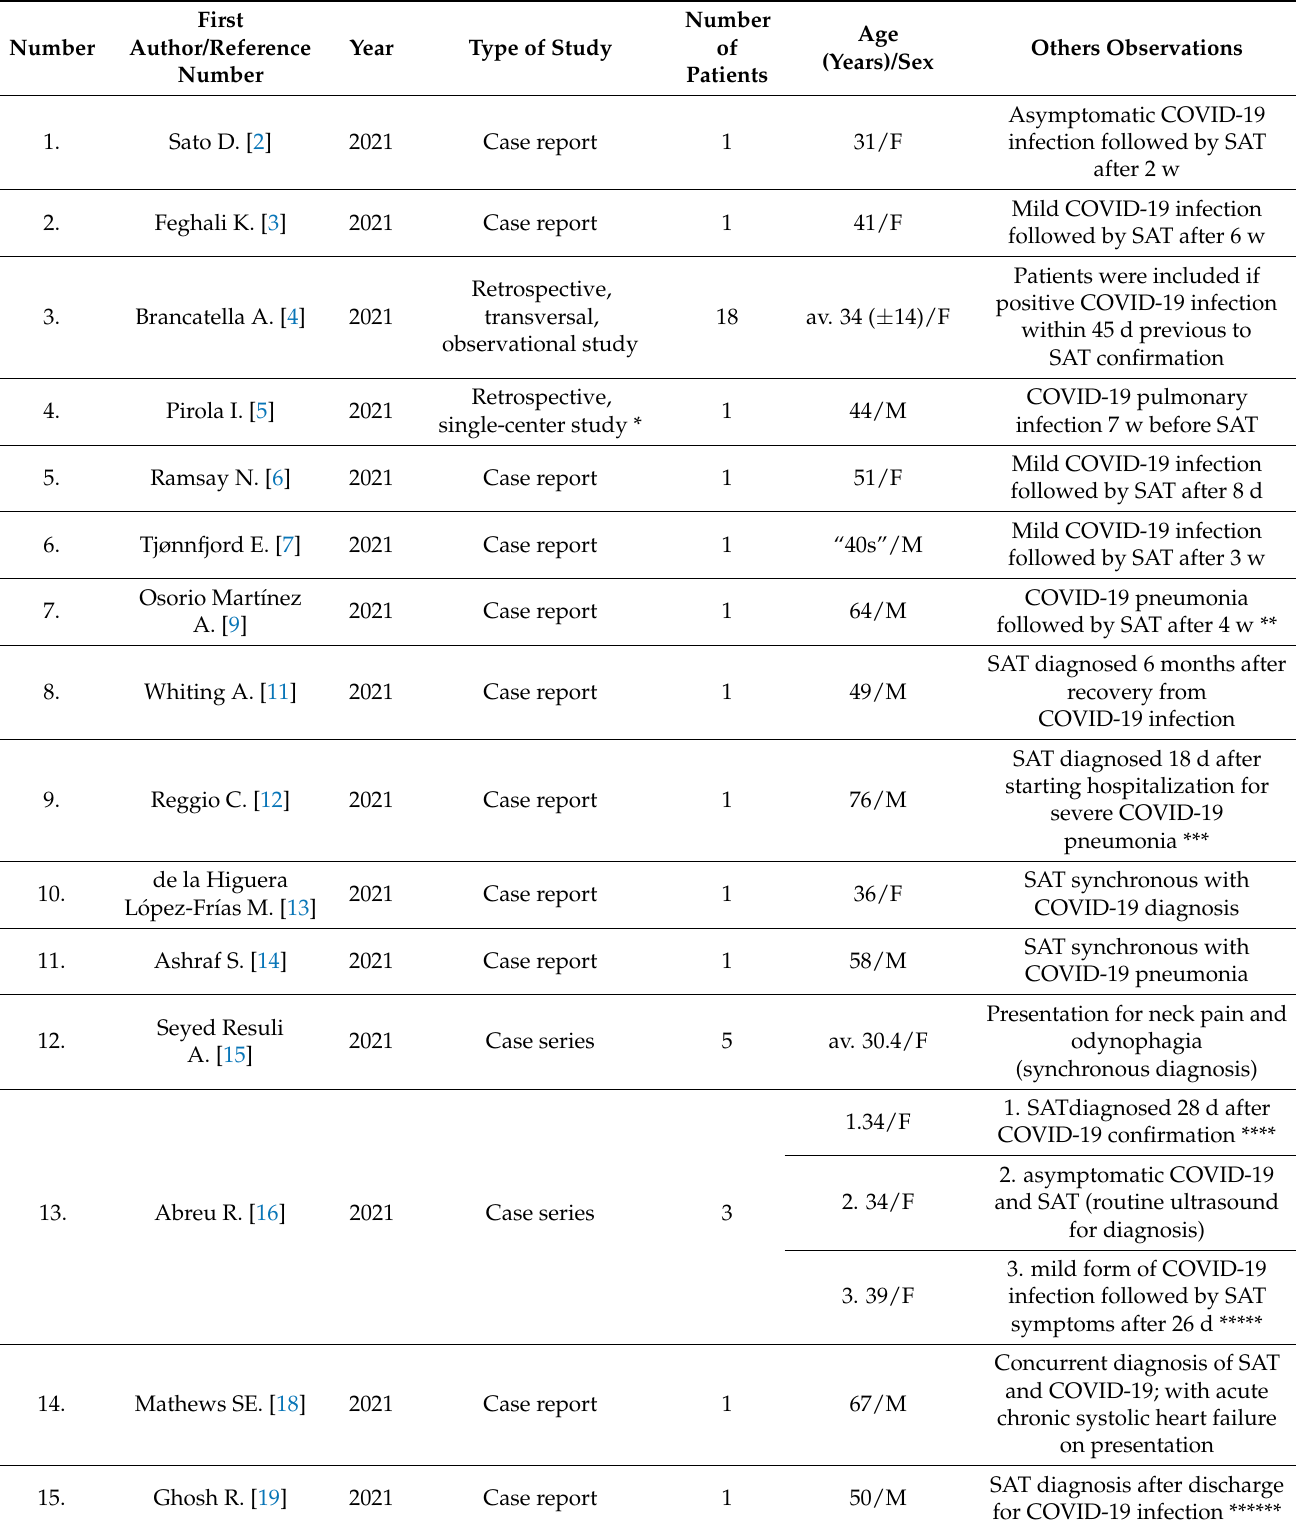
Table 1. All the cases that were published based on our previously mentioned research